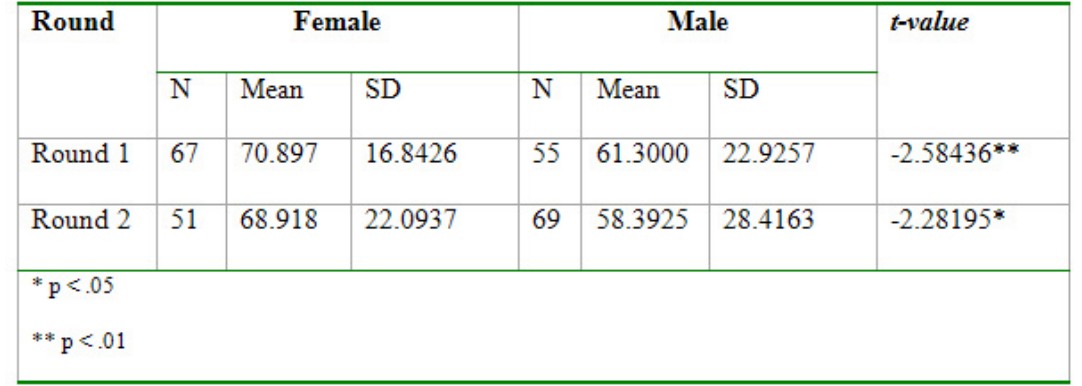
Table 4. Result of t-test on the Final Grades of All